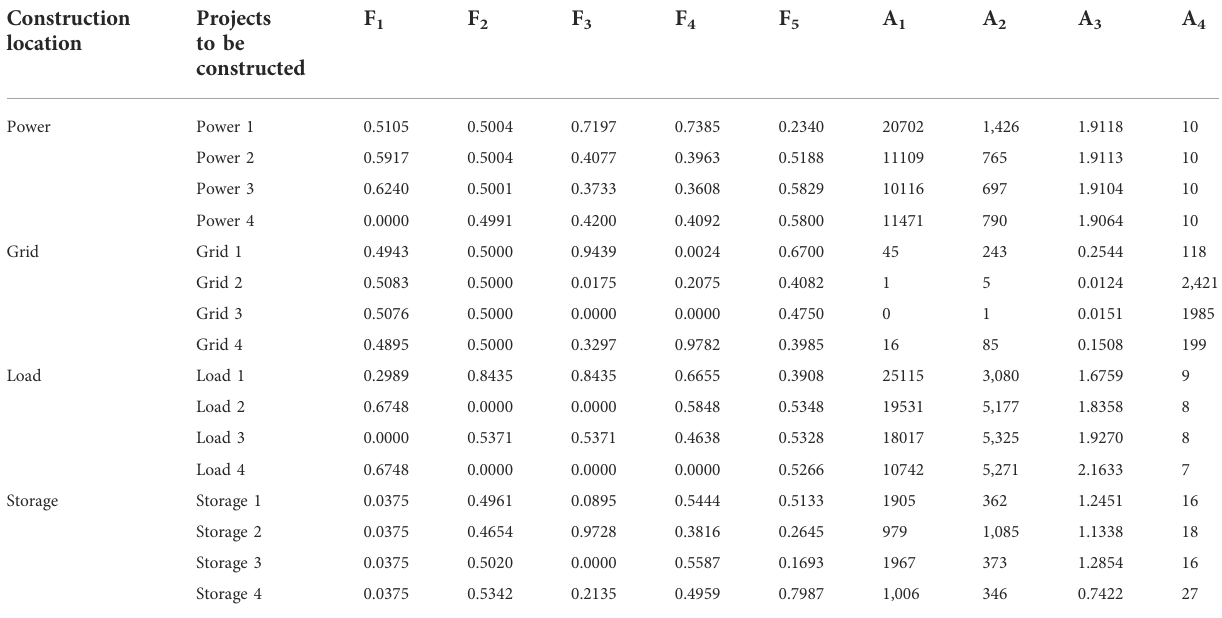
TABLE 5 Per value of indexes.